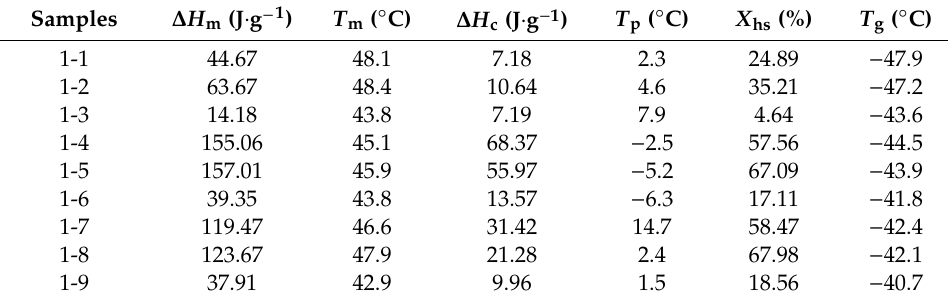
Table 9. Thermal transitions and relative crystallinity of polyester-based TPUs. Samples